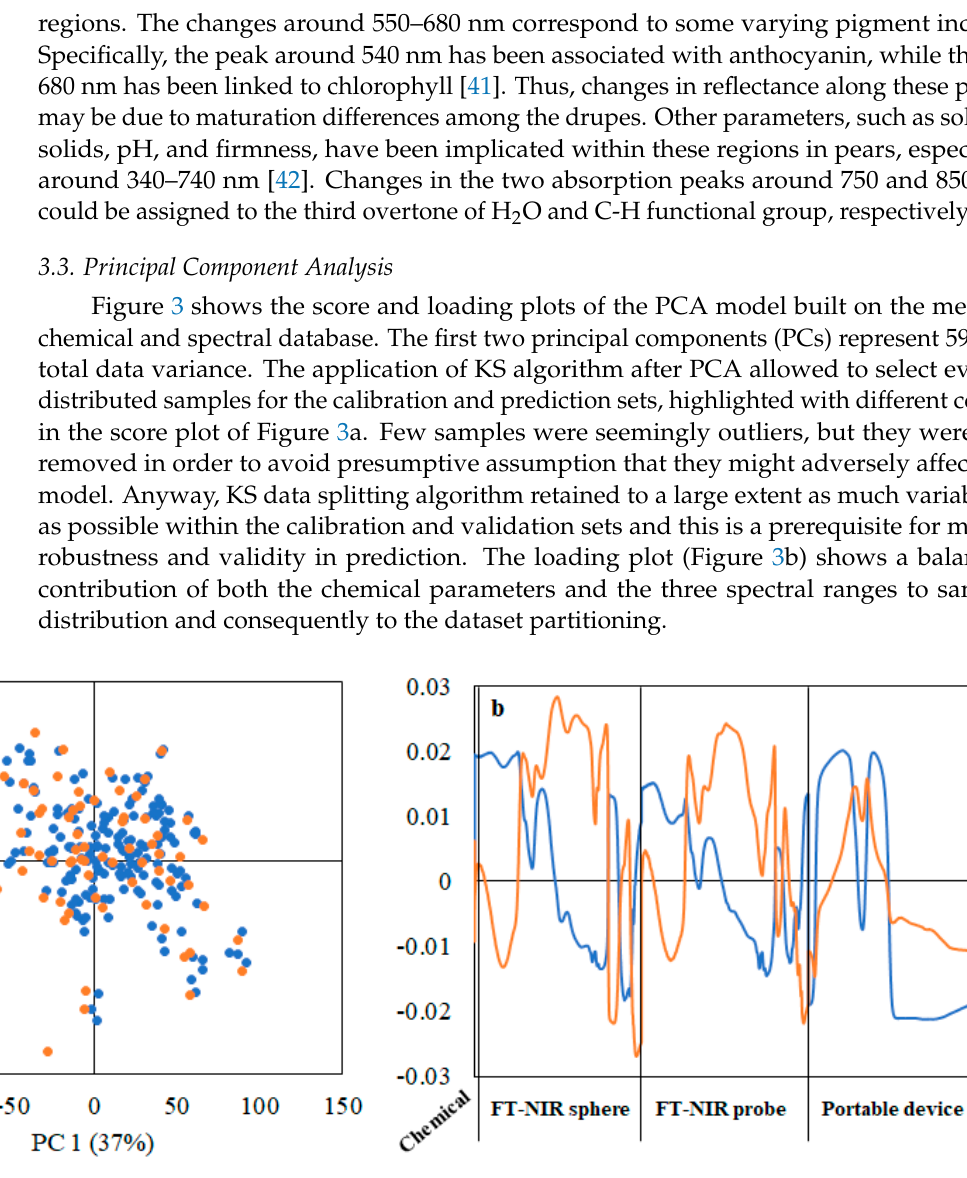
Figure 3. PCA results: ( a ) score plot showing the distribution of calibration (blue) and prediction (orange) set samples selected by Kennard-Stone algorithm applied on the merged chemical and spectral dataset of olive drupes; ( b ) loading plot of PC1 (blue) and PC2 (orange).